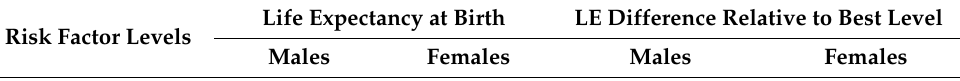
Table 4. Life expectancy at birth for selected levels of 23 environmental and occupational risk factors and differences relative to optimal